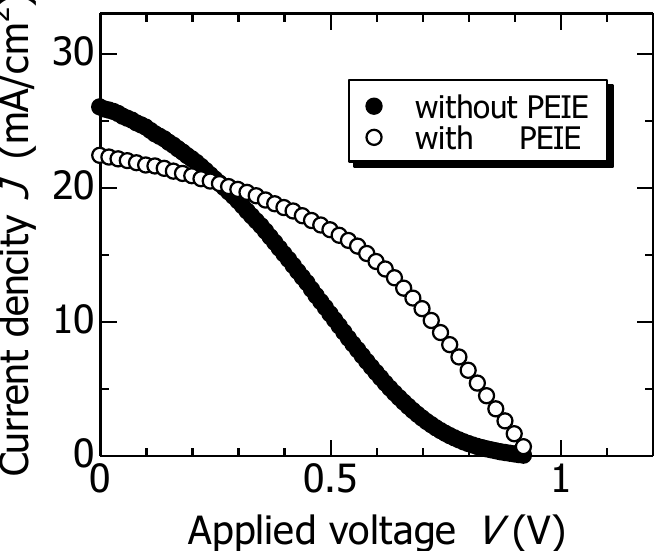
Figure 6. Linear J - V curve of photo-sensor without and with PEIE as electron injection layer using two-step method.